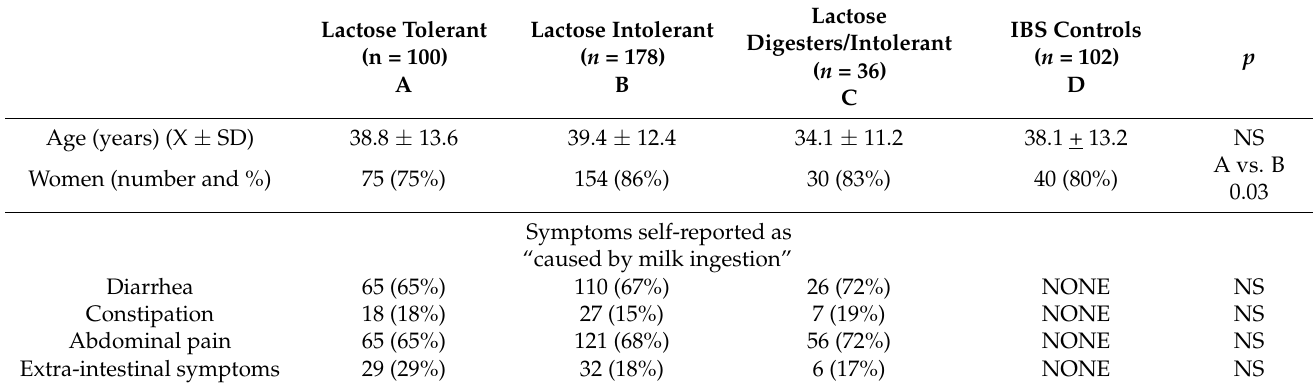
Table 1. Demographic characteristics and self-reported gastrointestinal symptoms in the 314 study subjects, grouped according to the LHBT results as “Lactose tolerant”, “Lactose intolerant”, and “Lactose digesters/intolerant”, and in the IBS controls who did not report milk